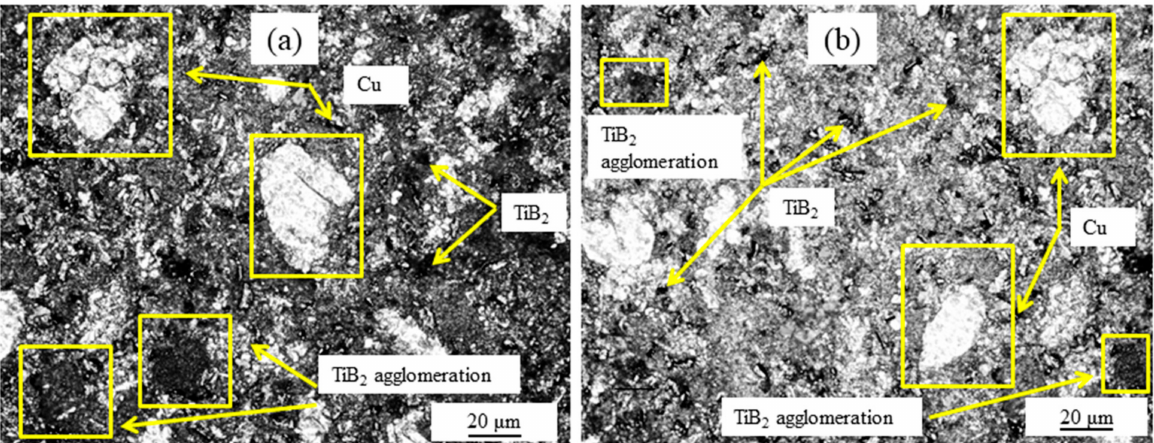
Figure 2. Optical microstructure of two types of composite: ( a ) Cu-2 wt% B-4 wt% Ti; ( b ) Cu-5 wt% B-10 wt%